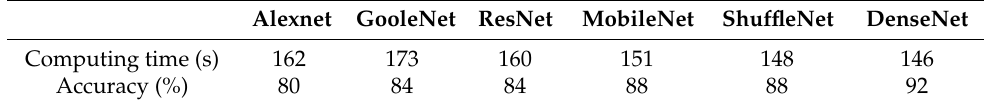
Table 2. Comparing the computing time and accuracy of different